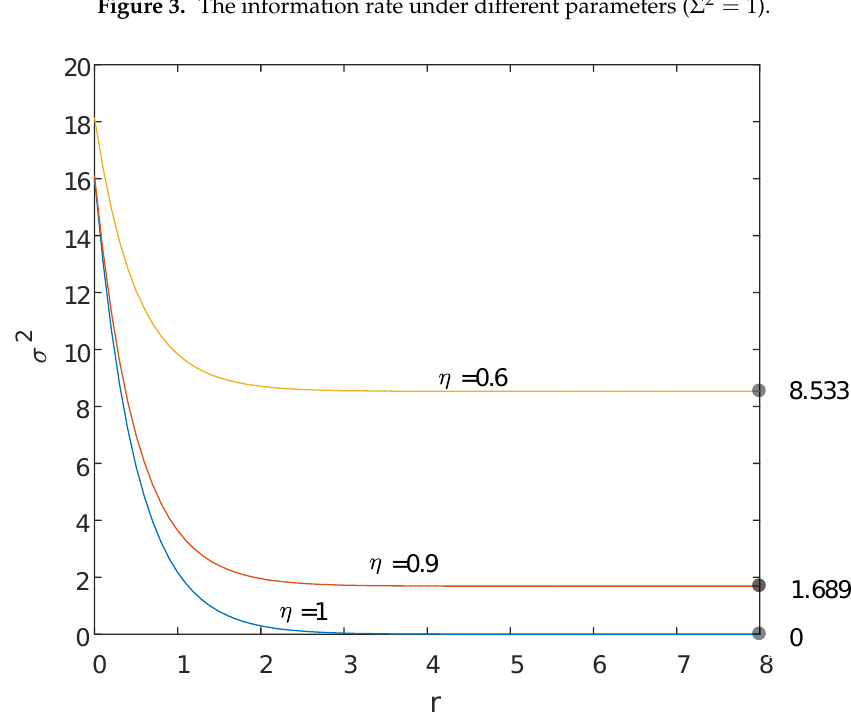
Figure 4. The relation between the squeezed parameter r and the variance of message σ 2 , when I ( S , R ) = log 3 2